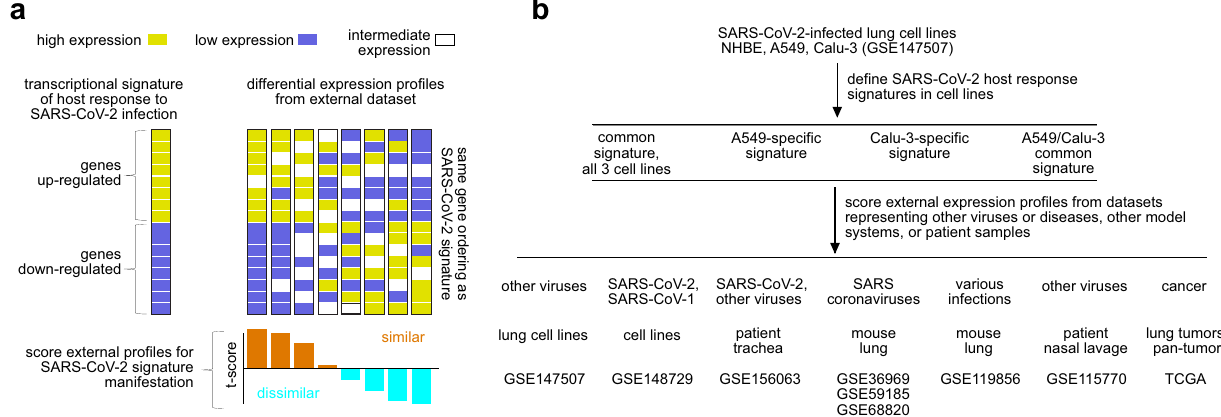
Figure 1. Overview of the basic approach of the study. ( a ) Diagram of the overall analytical approach to score a set of differential expression profiles according to a given gene transcription signature. For a given expression dataset, we score each mRNA profile according to an independently-derived transcriptional signature representing the host response to SARS-CoV-2 infection. The scoring basis is on whether the relative differential patterns in the external sample profile, higher versus lower, are broadly similar to the patterns of up- versus down-regulation, respectively, in the SARS-CoV-2 signature. The “t score” signature scoring metric from previous studies is used 34–37 . ( b ) Diagram of the study. We first defined transcriptional gene signatures of SARS- CoV-2 infection, using three different lung cell lines (NHBE, A549, Calu-3) 7 . We then applied these signatures to examine differential expression profiles from the indicated external transcriptome datasets representing other viruses or diseases, other model systems, or patient